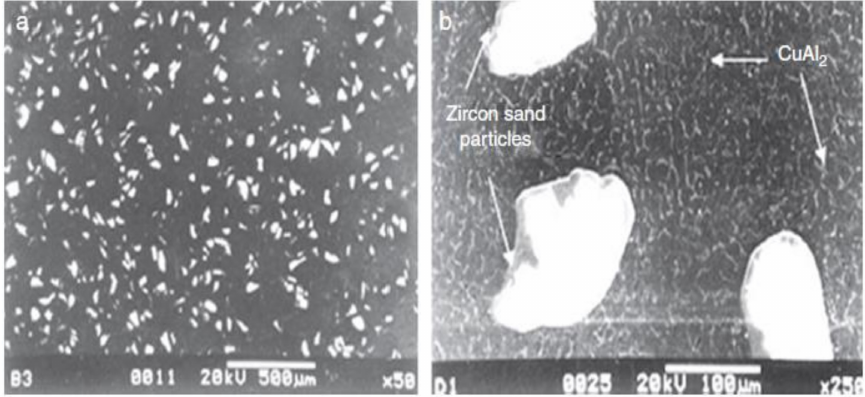
Figure 4. SEM images of MMCs showing ( a ) the identical distribution of zircon particles and ( b ) the existence of intermetallic segment [116].